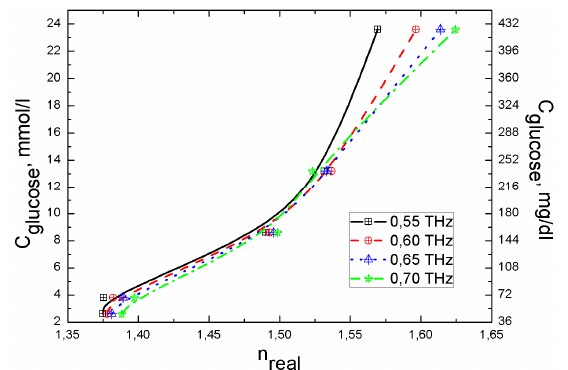
Fig. 1. Correlation between glucose concentration and re- fractive index had been observed at some frequencies Second group of experiments was performed to reassure in results and increase accuracy. To prevent blood coagulation, water evaporation and provide stable thickness of the blood layer, special container had been produced. [4] It consisted from bottom and top parts, produced from polymethyl methacrylate. There were 2 experiments where blood layer was lo- cated inside the container. Blood samples had been from the same patient up to 8 times per experiment.